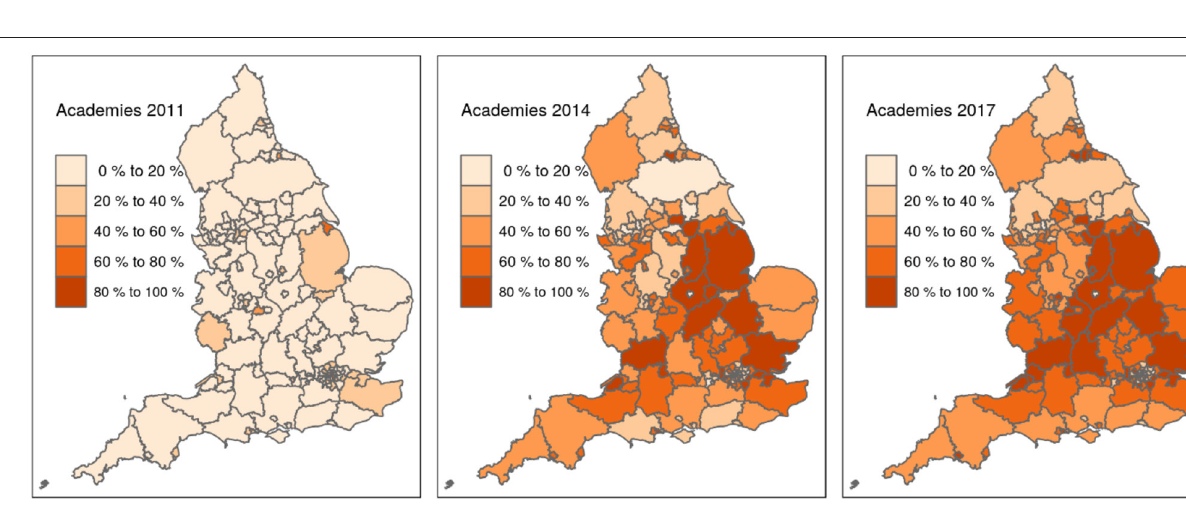
FIGURE 3 | Percentage of academies among English secondary schools by local authority in 2011, 2014, and